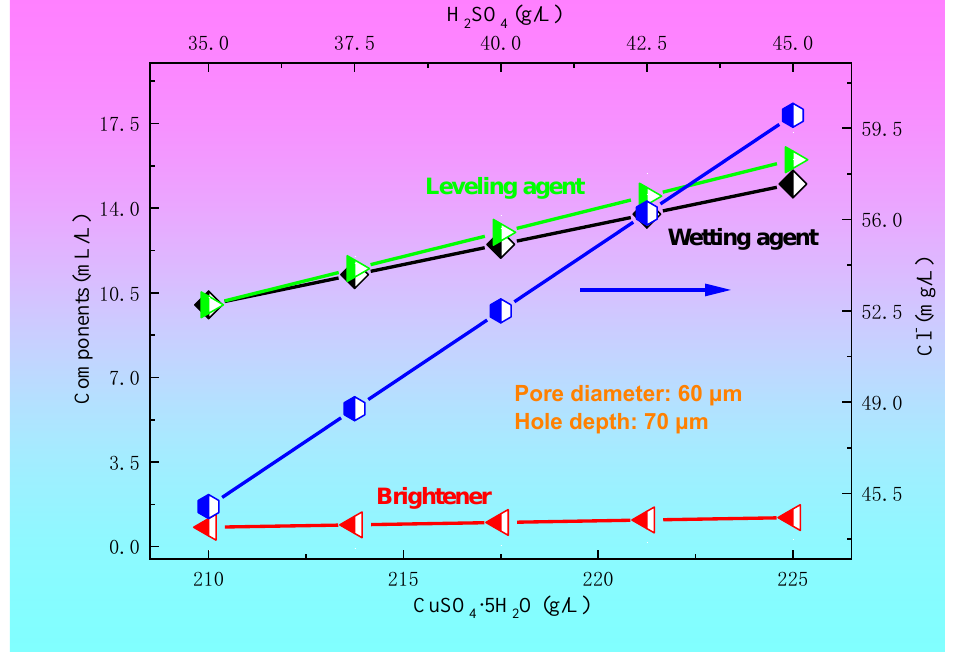
Figure 8. The relationships between the concentration of CuSO 4 · 5H 2 O and H 2 SO 4 and the plating solution formula for the blind hole with a diameter of 60 μm and a depth of 70 μm .